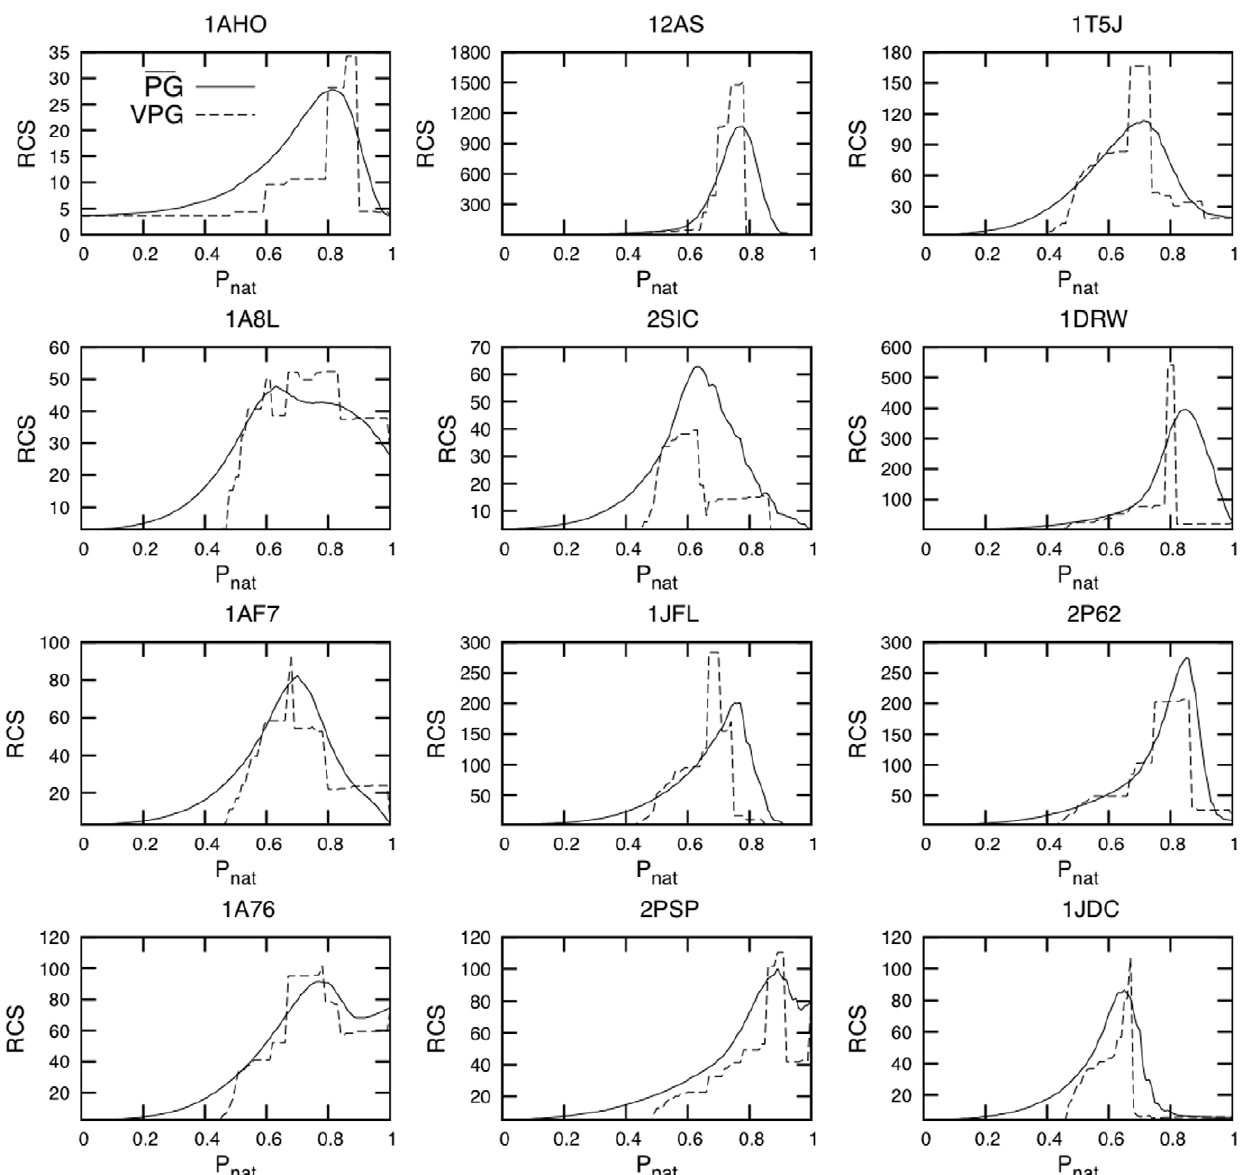
Figure 10. Rigid Cluster Susceptibility (RCS) is plotted versus P nat for 12 typical protein examples ( PG = solid line and VPG = dashed line). Note that the proteins presented in the first column are the same from Fig. 3a.